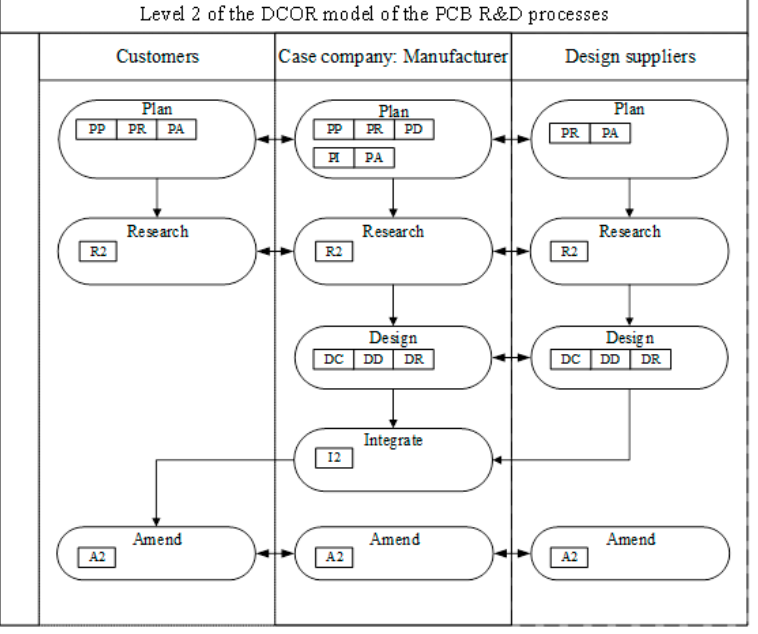
Figure 4. Level 2 of the DCOR model of the PCB R&D processes.